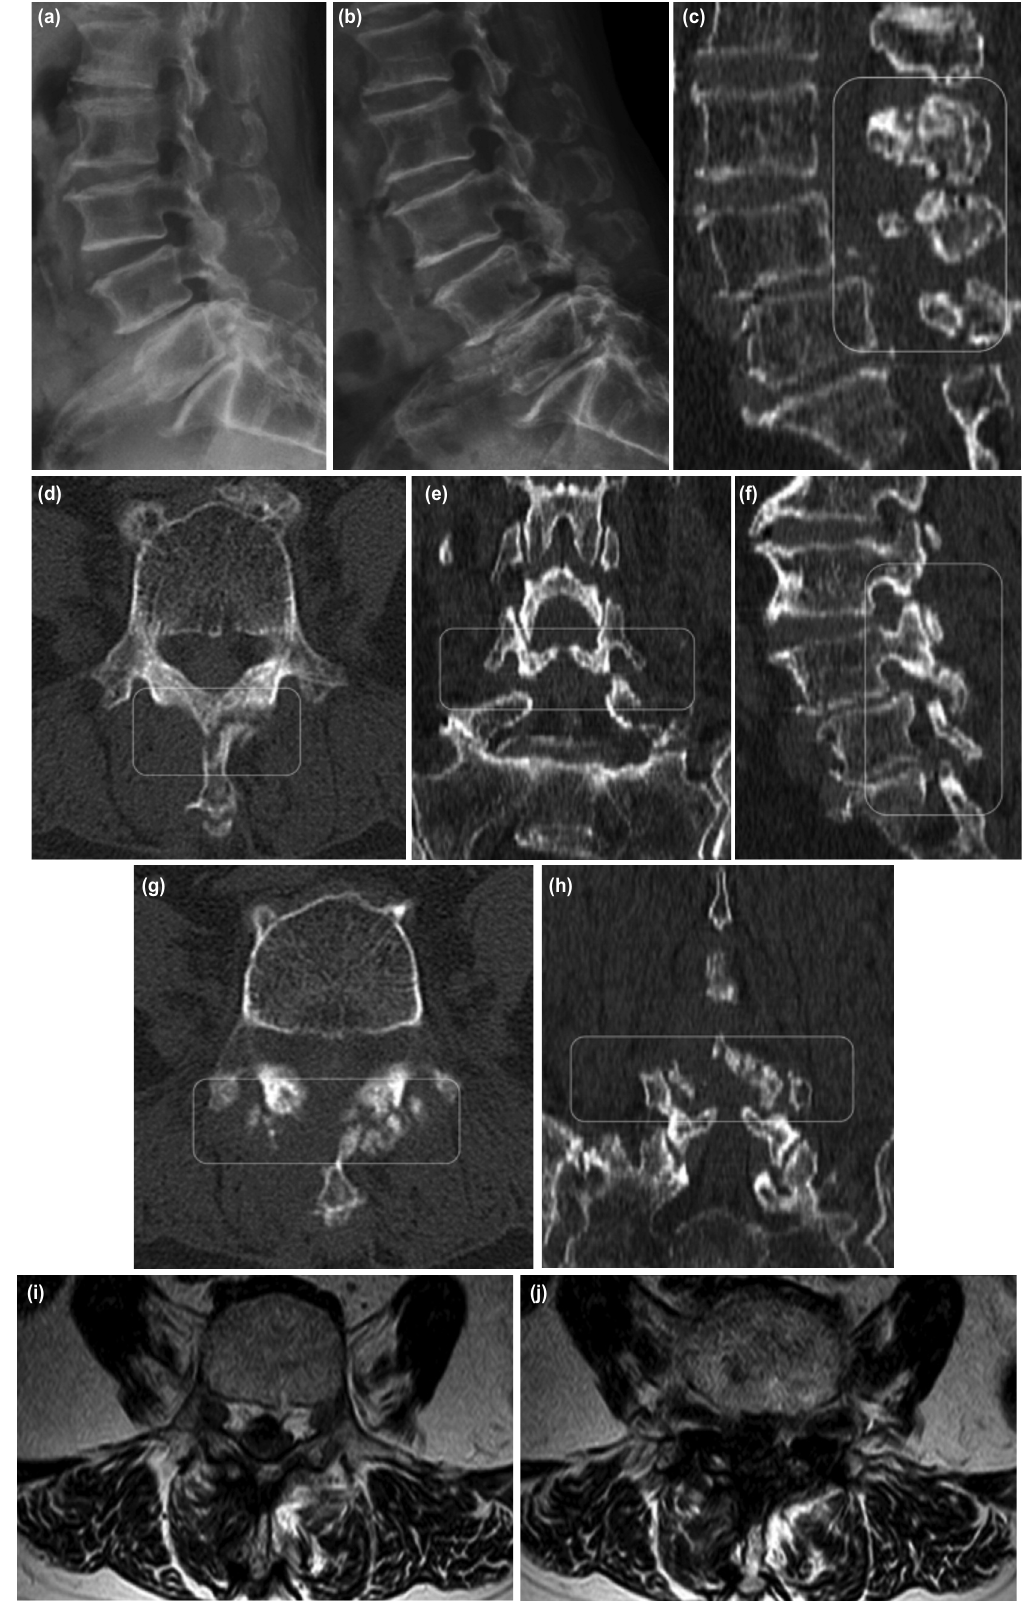
(a) Postoperative lateral radiograph at the time of BE-ULBD (b) and three months follow-up. (c, d, e) MRI and CT imaging for Fig. 2: three months after the first surgery (BE-ULBD. Pre-operative CT cut showed a stress fracture of posterior arch at L3, (f, g, h) and L4 (white rounded rectangle). (i) Pre-operative T2 weighted MRI axial cut L4 spondylolytic spondylolisthesis, severe herniated nucleus pulposus and L3 and L4 posterior arch fracture. (j) Axial cut at L4-L5